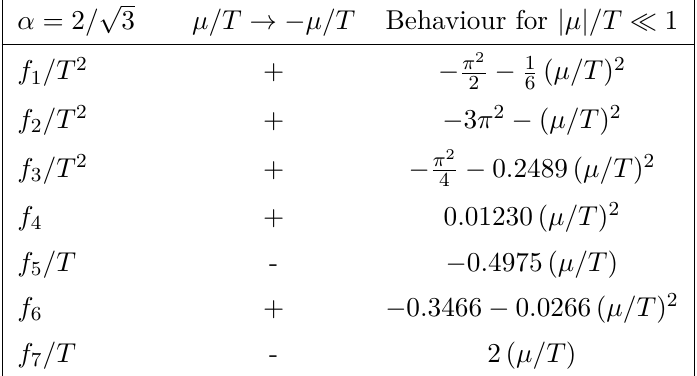
Table 3 . Behaviour of the susceptibilities under a parity transformation µ → − µ and polynomial fits for small chemical potentials | µ | /T (cid:28) 1 . Recall that the axial chemical potential µ is P -odd and C